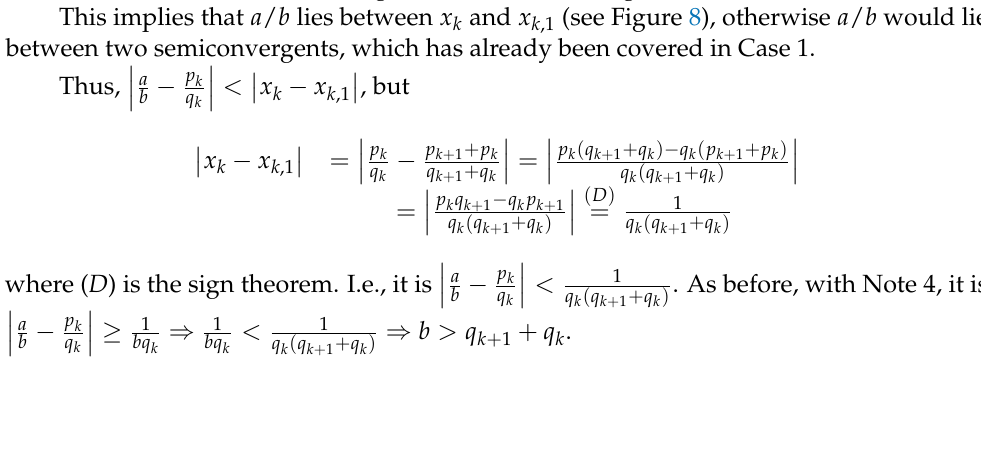
Figure 15. Distances within an interval of convergents ( k even). Case 3. a / b lies between a convergent and a